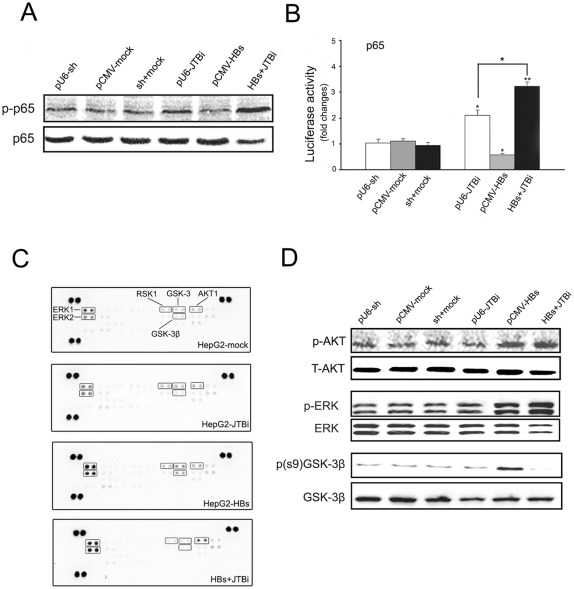
Activity of p65 and other protein kinases in HCC cell lines.The transcriptional activity of p65 was measured indirectly using luciferase reporter assays and normalized against TK-renilla. (A) Immunoblot analysis for phospho-p65 and total p65 protein expression. Increased phosphorylation of p65 was detected in both pU6-JTBi and HBs+JTBi cells, whereas HBs inhibited p65 phosphorylation. (B) Transcriptional activity of the p65 promoter in HepG2 cells using the luciferase activity assay was consistent with the level of p65 phosphorylation. The data were expressed as the mean of three experiments and as a percentage of the p65 promoter activity compared to that in the HepG2-vector cells (100%). (C) The results of the Human Phospho-MAPK Array Kit (R&D Systems, Inc.) In addition, we determined the relative levels of phosphorylated mitogen-activated protein kinases (MAPKs) and other serine/threonine kinases. (D) The phosphorylation levels of AKT, ERK and GSK-3β were detected by western blot analysis.